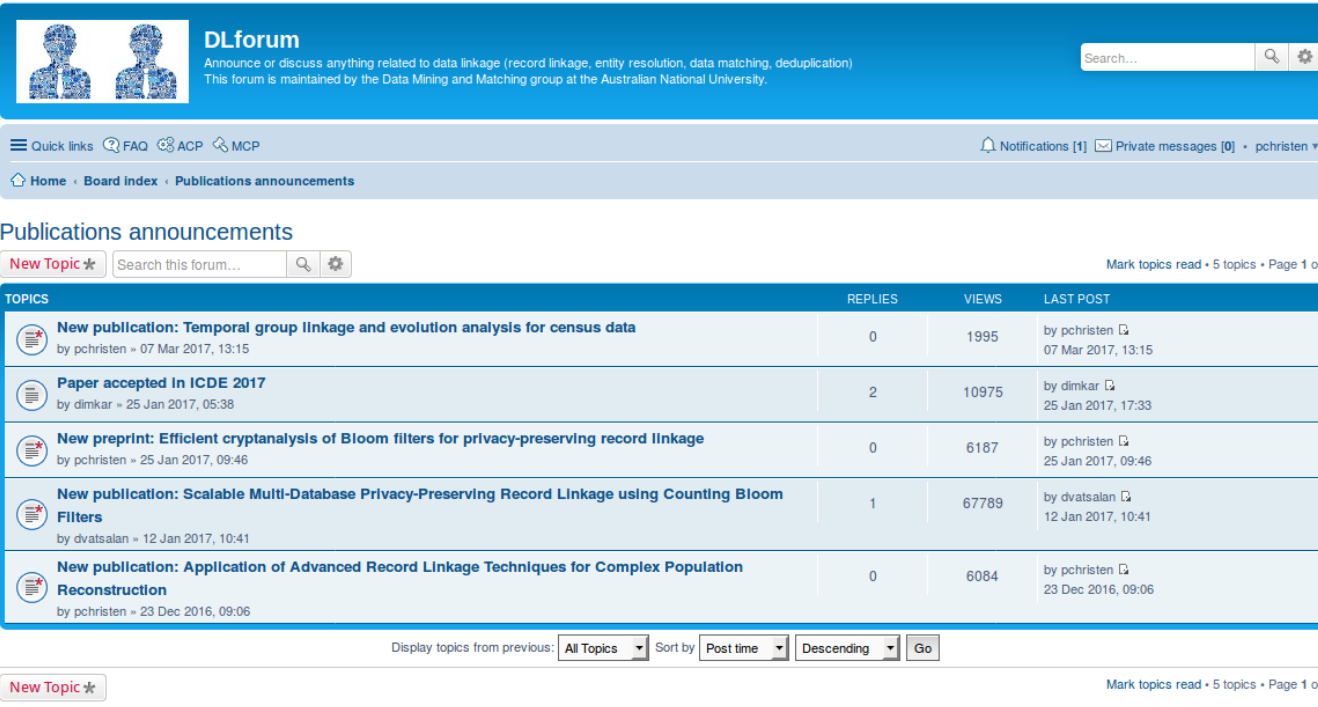
Figure 2: Publication announcements forum area showing several individual